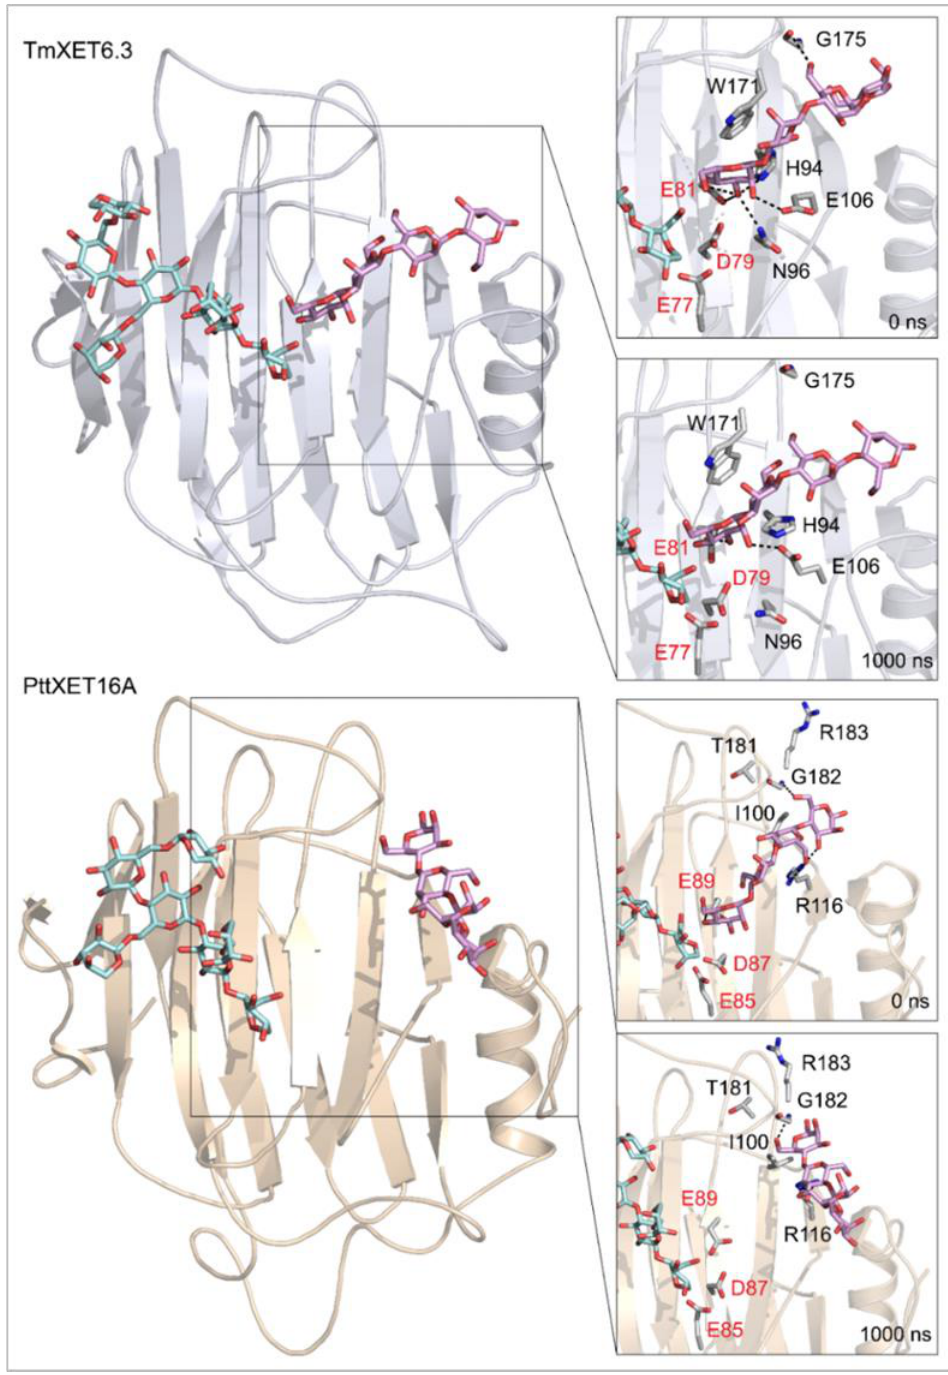
Figure 5. Positions of the XG-OS7 donor and docked Man-OS4 acceptor substrates in TmXET6.3 or PttXET16A (left). The residues that interact with acceptors over 50% of MD simulation times at distances of up to 4.0 Å (right, black letters) are shown at the beginning (0 ns) and after 1000 ns of MD simulation times. Catalytic residues are shown in red letters.